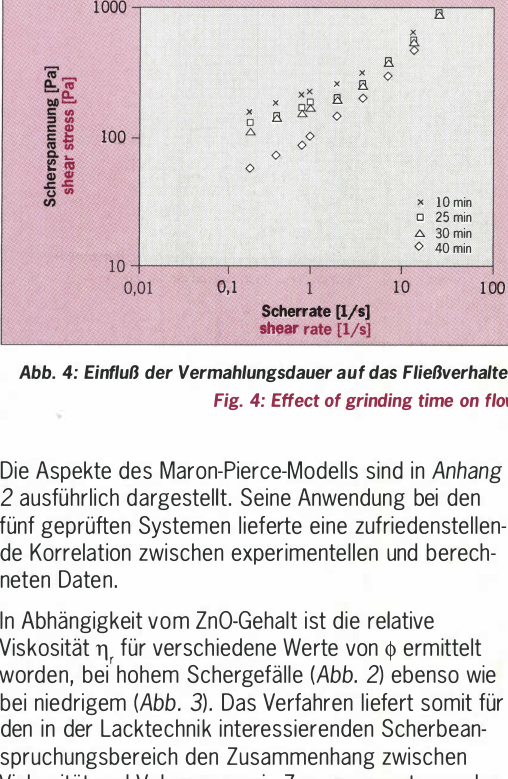
Abb. 3: Relative Viskositiit bei niedrigem Schergefiille als Funktion vom ZnO-Gehalt Fig. 3: Relative viscosity at low shear rates as a cuntion of the ZnO content